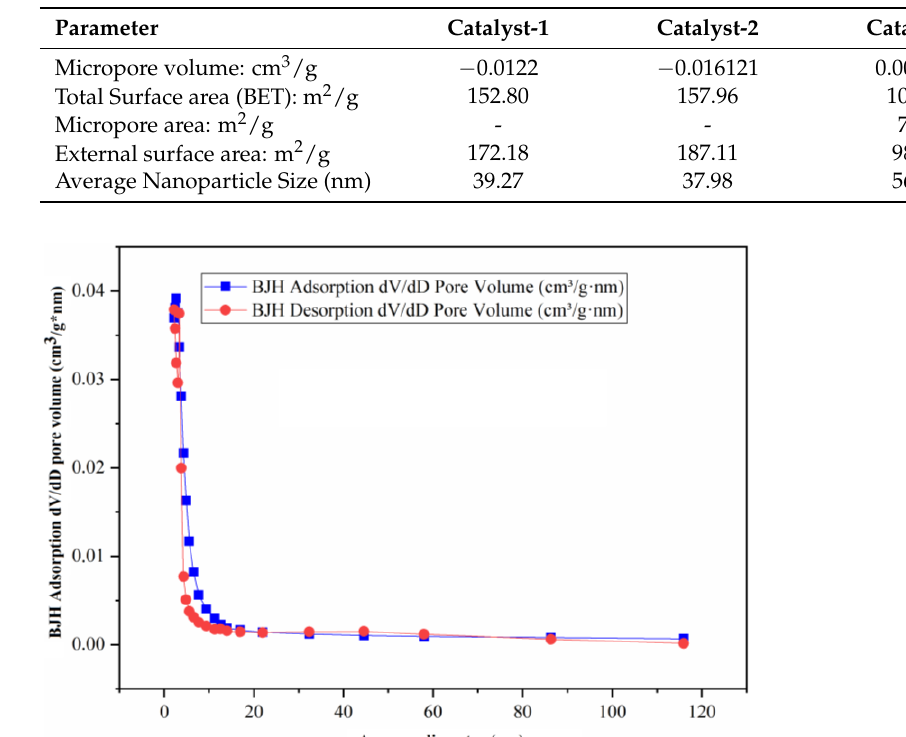
Figure 5. BJH Adsorption and desorption pore volume of catalyst - 1.